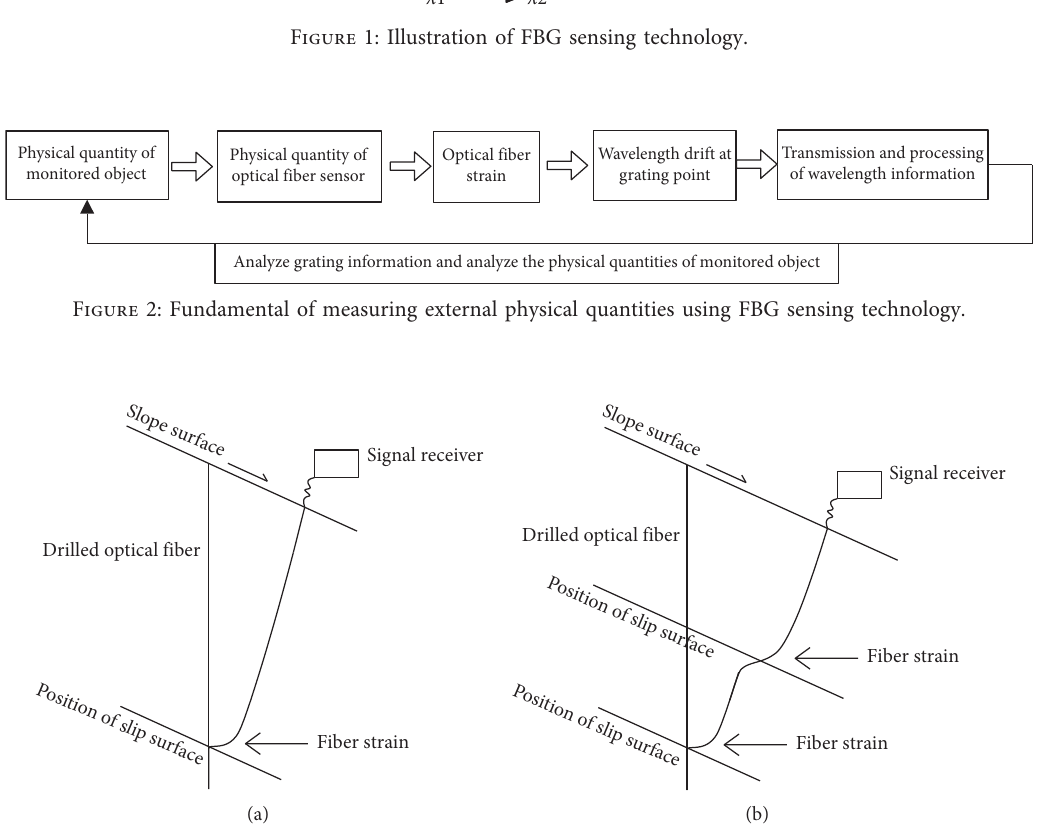
Figure 3: Fundamental of the monitoring of landslide internal deformation using fiber grating. (a) Single slip surface of landslide. (b) Multilayer slip surface landslide.